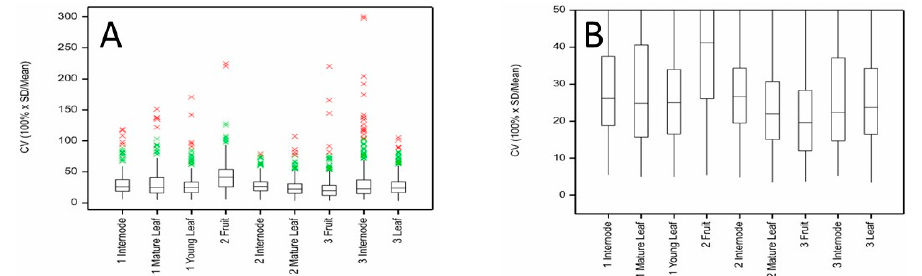
Figure 3. Distributions of coefficients of variation (CV) for metabolites measured by LC-MS in ‘Zesy002’ kiwifruit internode, mature and young leaf and fruit tissues at three harvest times showing ( A ) the full range of CV values and ( B ) the interquartile ranges.